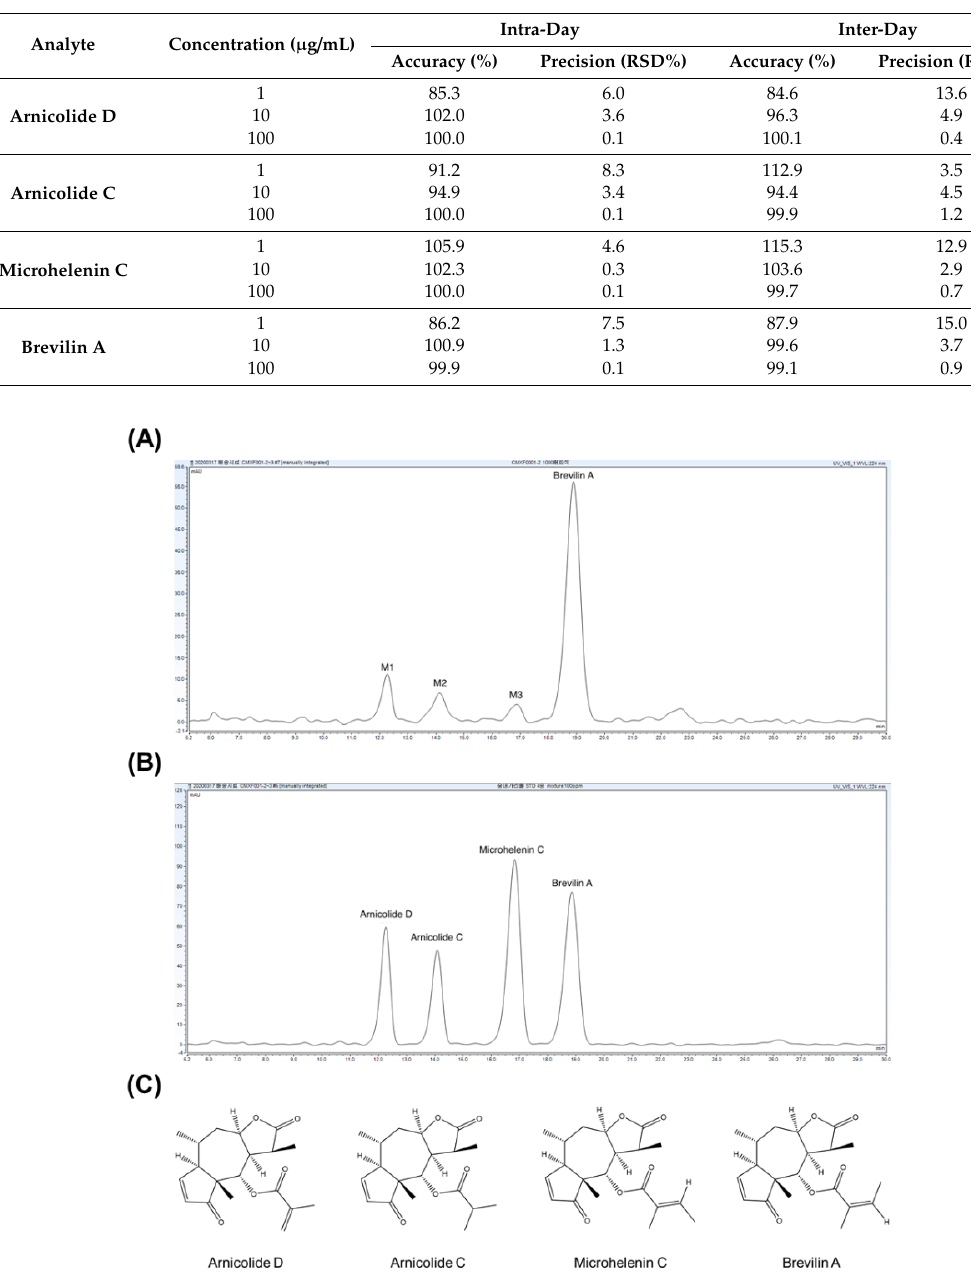
Table 1. Intra- and inter-day precision and accuracy of four compounds (n = 3).